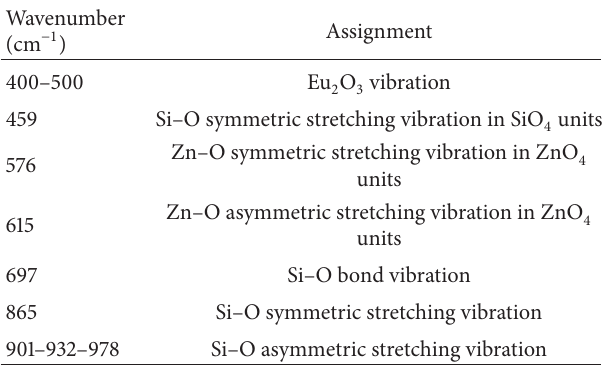
O doped willemite-based glass 2 3